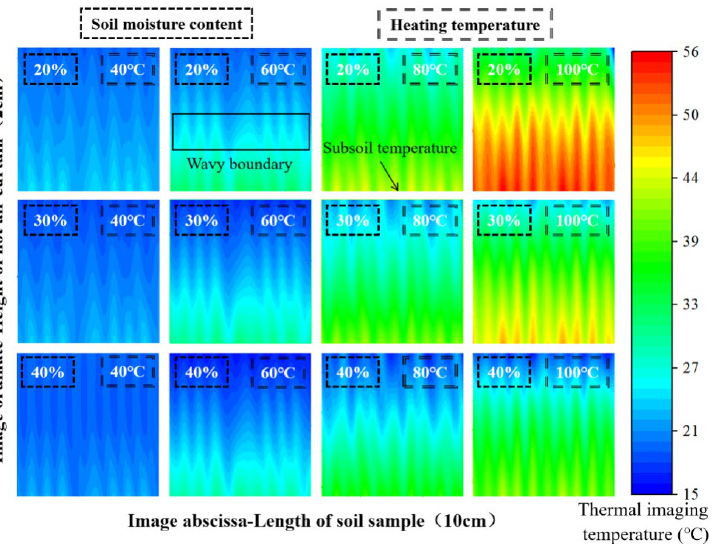
Figure 10. Thermal images of high-pressure hot air curtain for soil samples with moisture contents of 20%, 30%, and 40%.